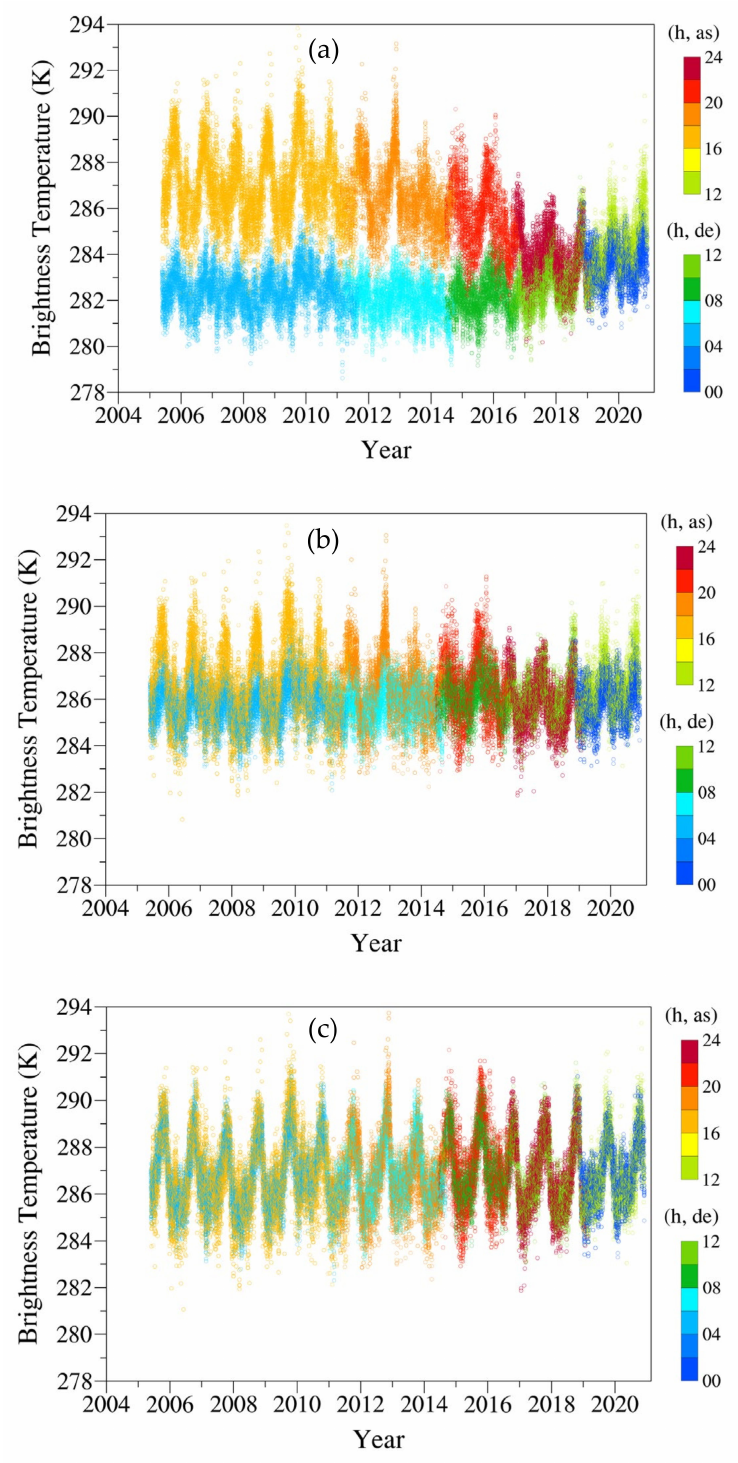
Figure 13. Same as Figure 12 except for NOAA-18 of ( a ) without any correction, ( b ) after inter-sensor bias correction, and ( c ) after inter-decadal diurnal